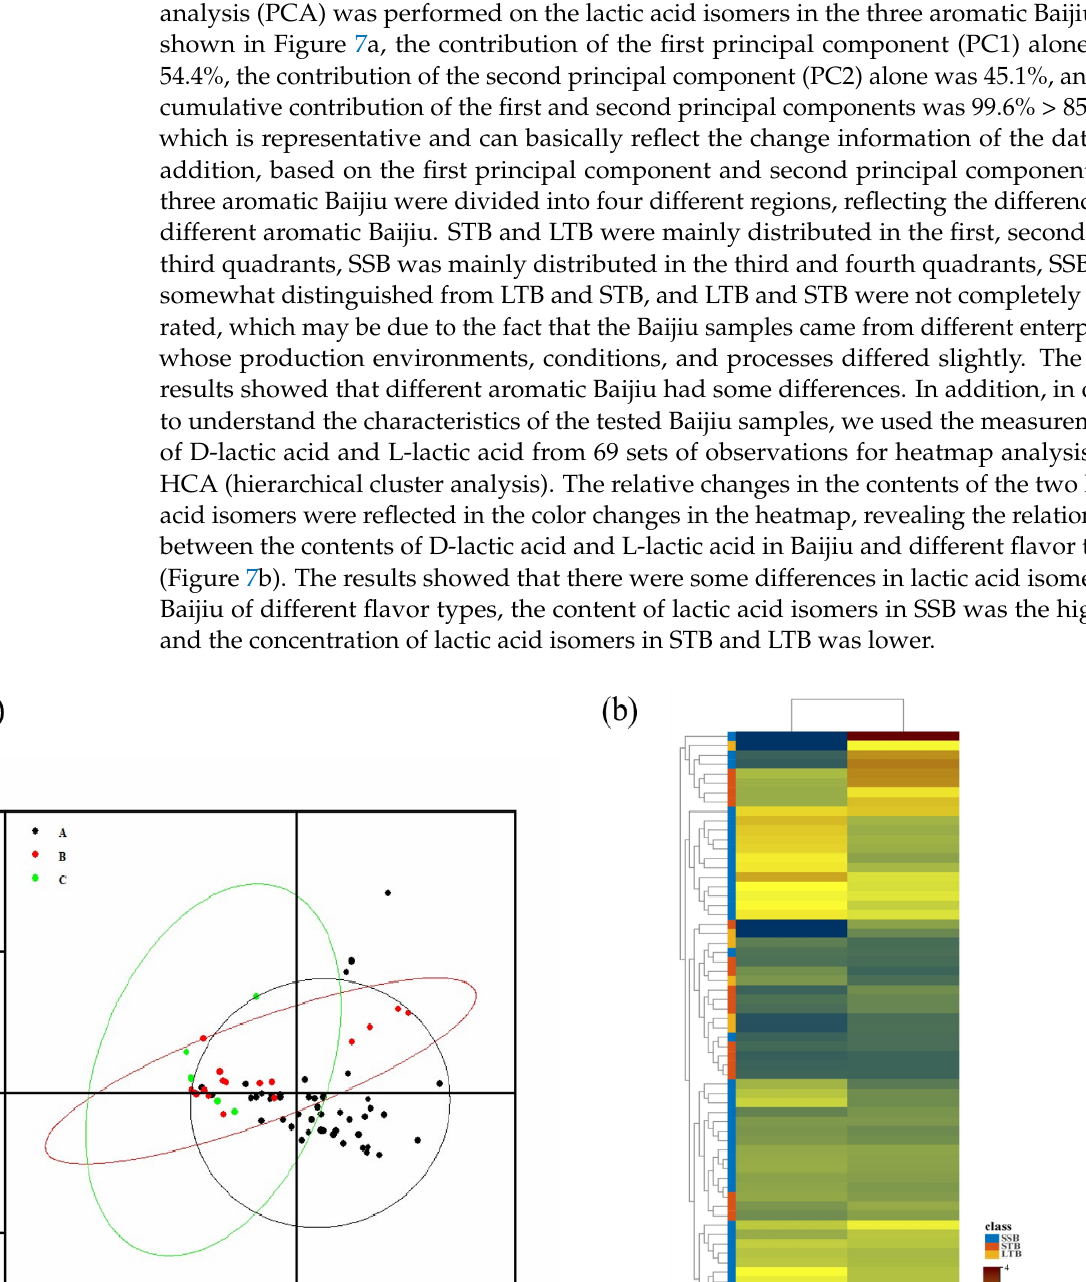
Figure 6. ( a , b , c ) Histograms of D-lactic acid and L-lactic acid in soy sauce aroma-type vintage Baijiu (JSHS, XJCT) and strong aroma-type vintage Baijiu (LZLJ).